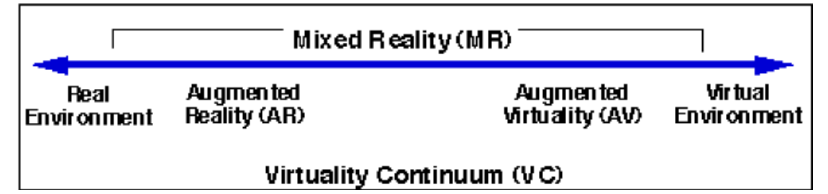
Figure 1. Representation of the “ virtuality continuum .”